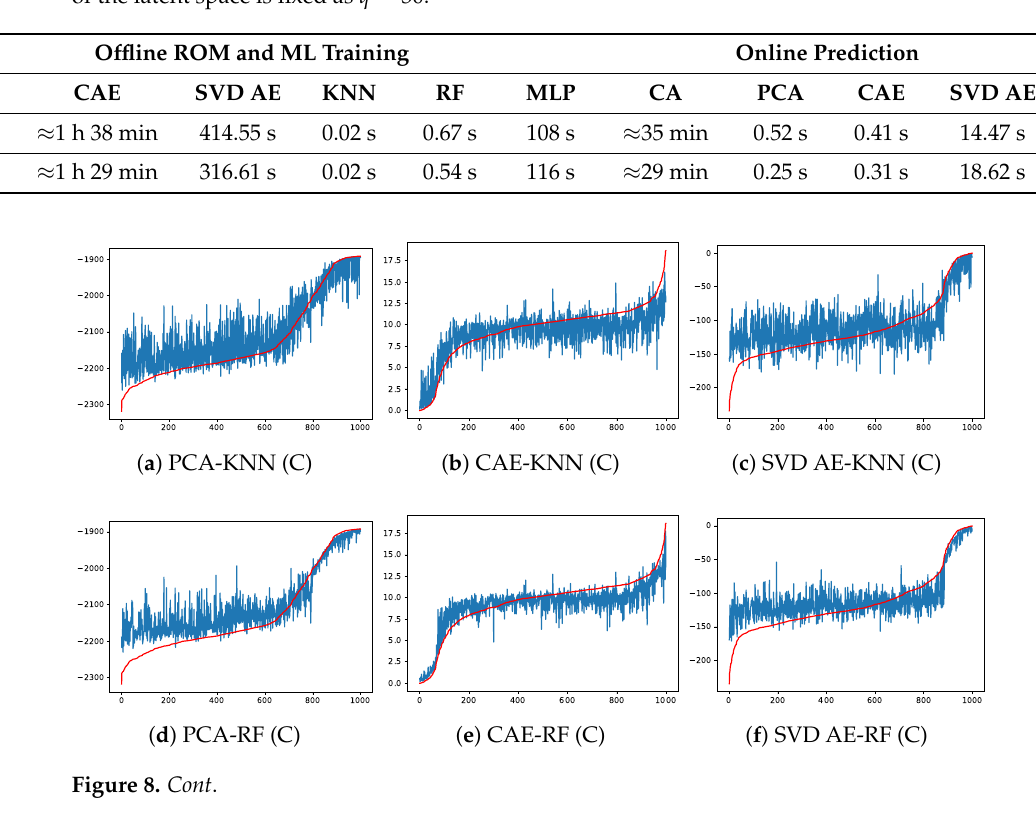
Table 5. Averaged computational time for offline training (on the training dataset of 1000 samples) and online prediction(for each sample including decoding) for different ROMs using RF. The dimension of the latent space is fixed as q = 30.